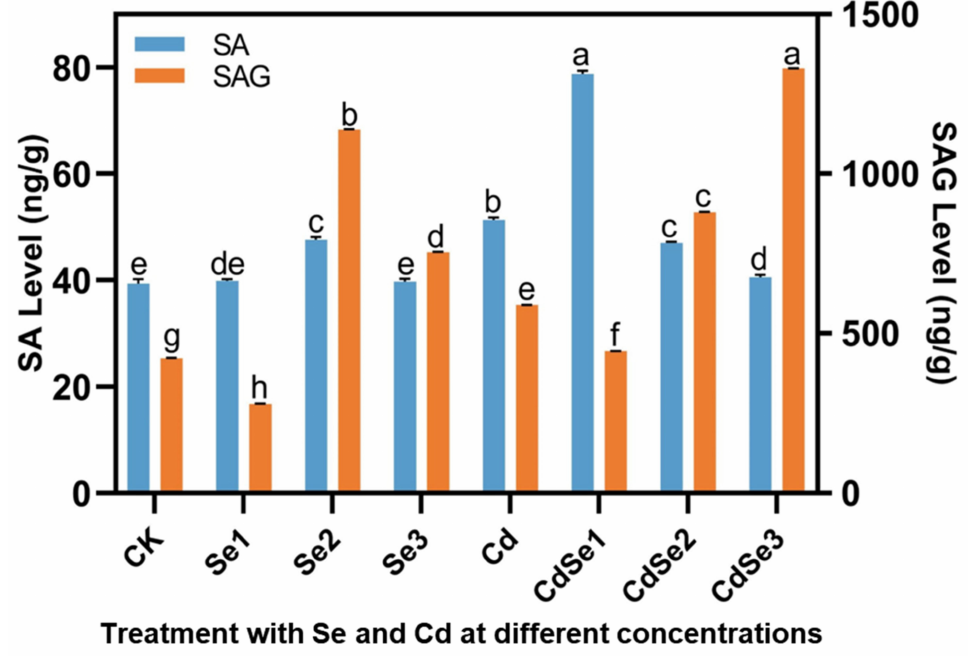
Figure 9. Changes of SA content in mustard with different concentrations of CdCl 2 and Na 2 SeO 3 . The error bar represents the standard deviation. The lowercase letter a to h on the bar reflects the 5% significant level. SA, salicylic acid; SAG, Salicylate